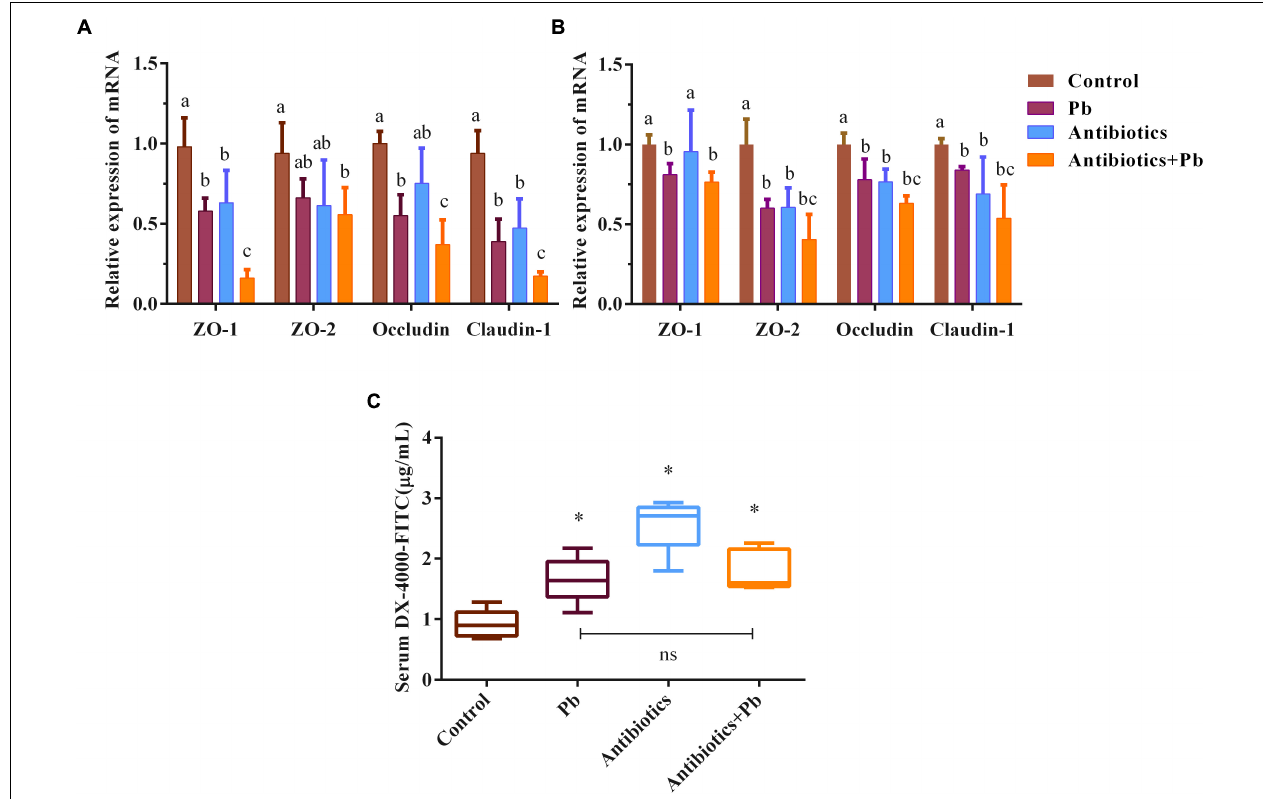
FIGURE 2 | The effects of antibiotic treatment on the gut barrier function of mice ( n = 5). mRNA expression of TJ proteins ZO-1, ZO-2, occludin and claudin-1 in representative sections of the colon (A) and small intestine (B) of mice. β -actin was used as the internal control. The data are expressed as the fold-change vs. control group (set to 1). Letters a–c denote statistically significant differences between each group ( p < 0.05). (C) DX-4000-FITC levels in the serum of mice, ∗ p < 0.05 vs. the control group. “ns” indicates no significant differences ( p > 0.05) between